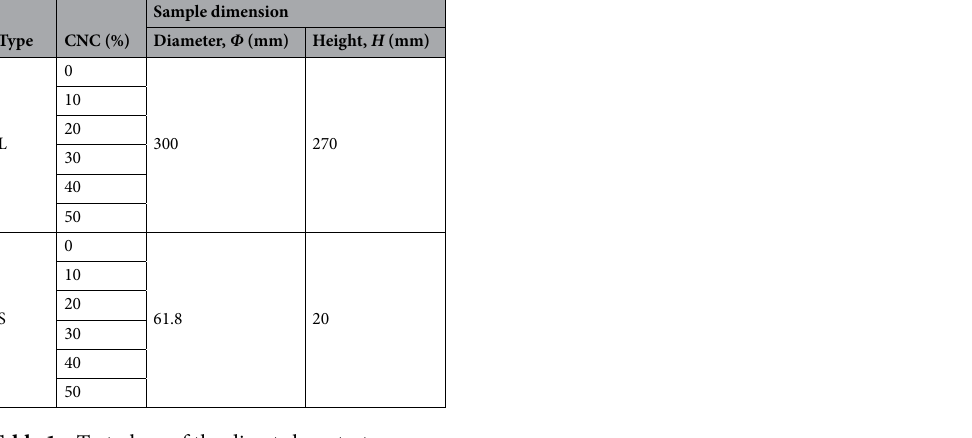
Table 1. Test plans of the direct shear